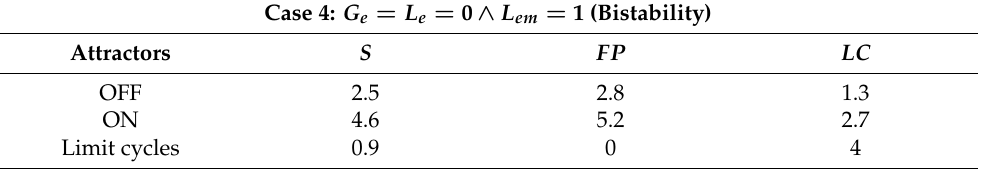
Table 5. Average size of the attraction basin for case 4 of the reduced model (Section 3.2) and calcu- lated over the set S 3 , FP and LC (see definitions in Table 3). Its respective sizes are | S 3 | = 13 (100%), | FP | = 10 (77%) and | LC | = 3